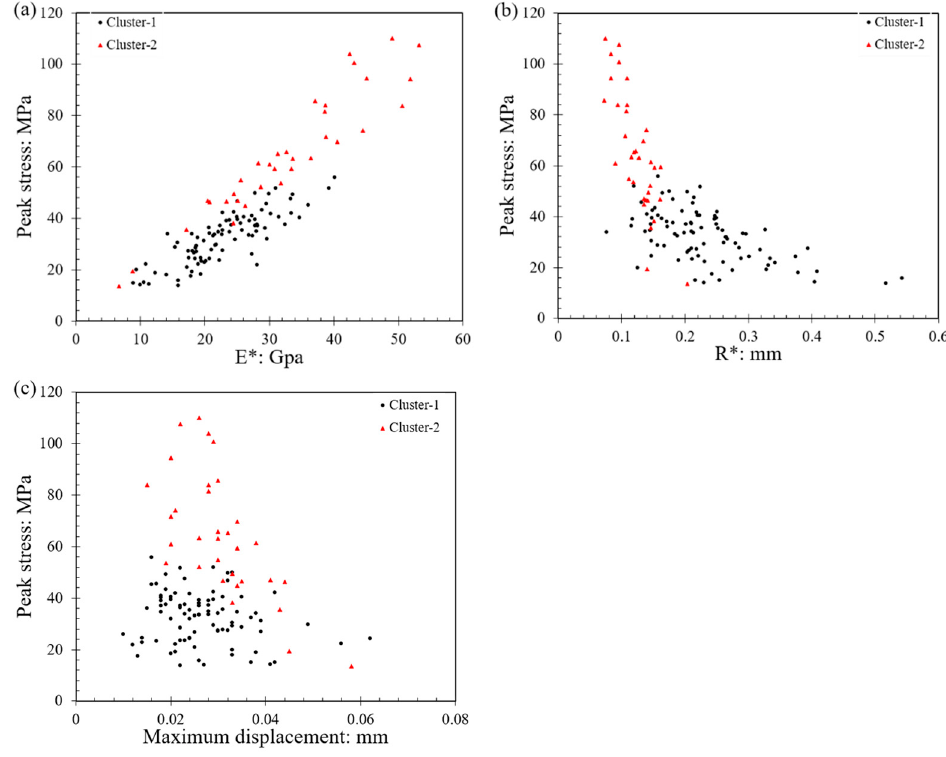
Figure 13. Clustering analysis investigating ( a ) the relationship between the equivalent modulus and the peak stress, ( b ) the relationship between the equivalent radius and the peak stress, ( c ) the relationship between the maximum displacement (corresponding to peak load) and the peak stress.